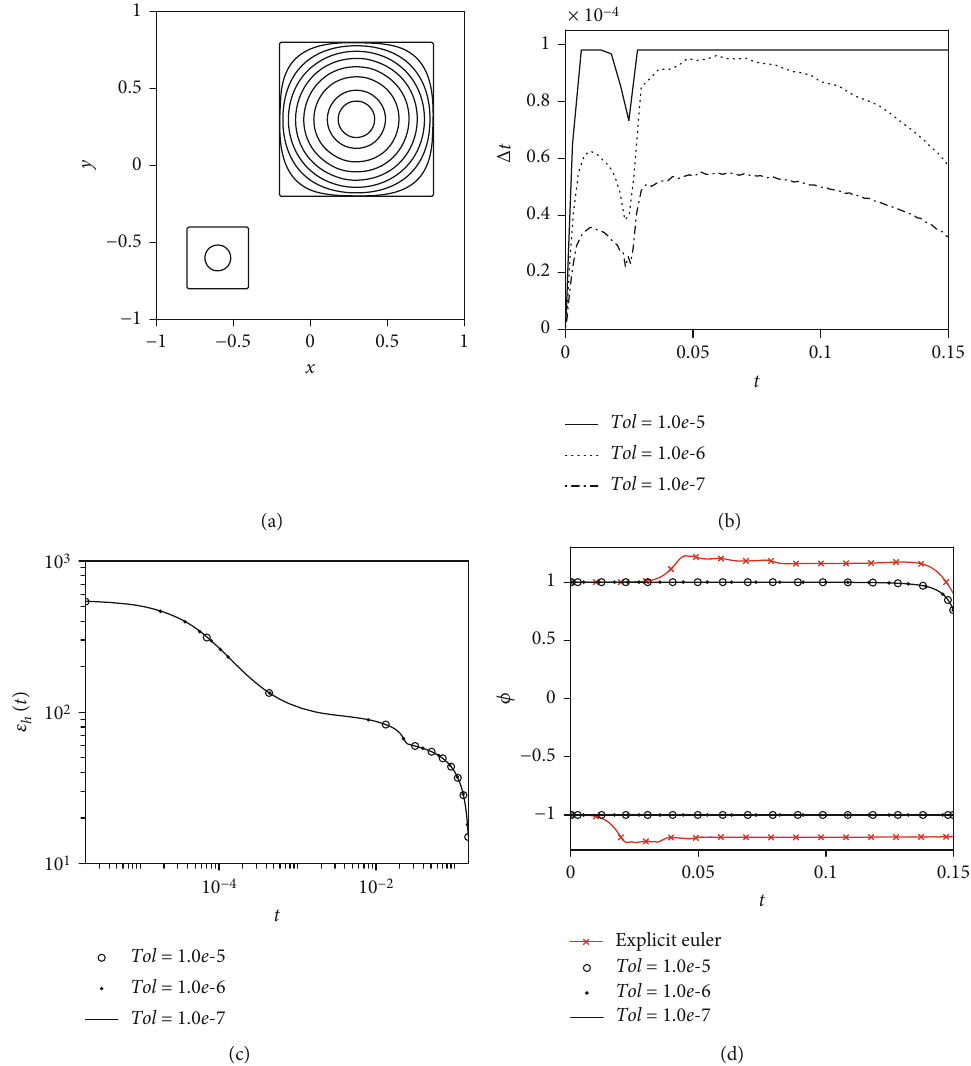
Figure 7: Temporal evolution with the initial states (16): (a) zero level contour of ϕ ð x , y , t Þ with tol = 1 : 0 e - 7 ; (b – d) the changes in the time step size Δ t , the discrete total energy E h ð t Þ , and the maximum and the minimum of ϕ with di ff erent tol = 1 : 0 e - 7 . Numerical tests are conducted to observe the changes in the time step Δ t over time t as shown in Figure 6(b) according to the di ff erent tolerance values tol . When a relative large tolerance is used, the time step is Δ t = Δ t max except the early times where there are sharp cor- varies adaptively. It takes small time steps at not only the